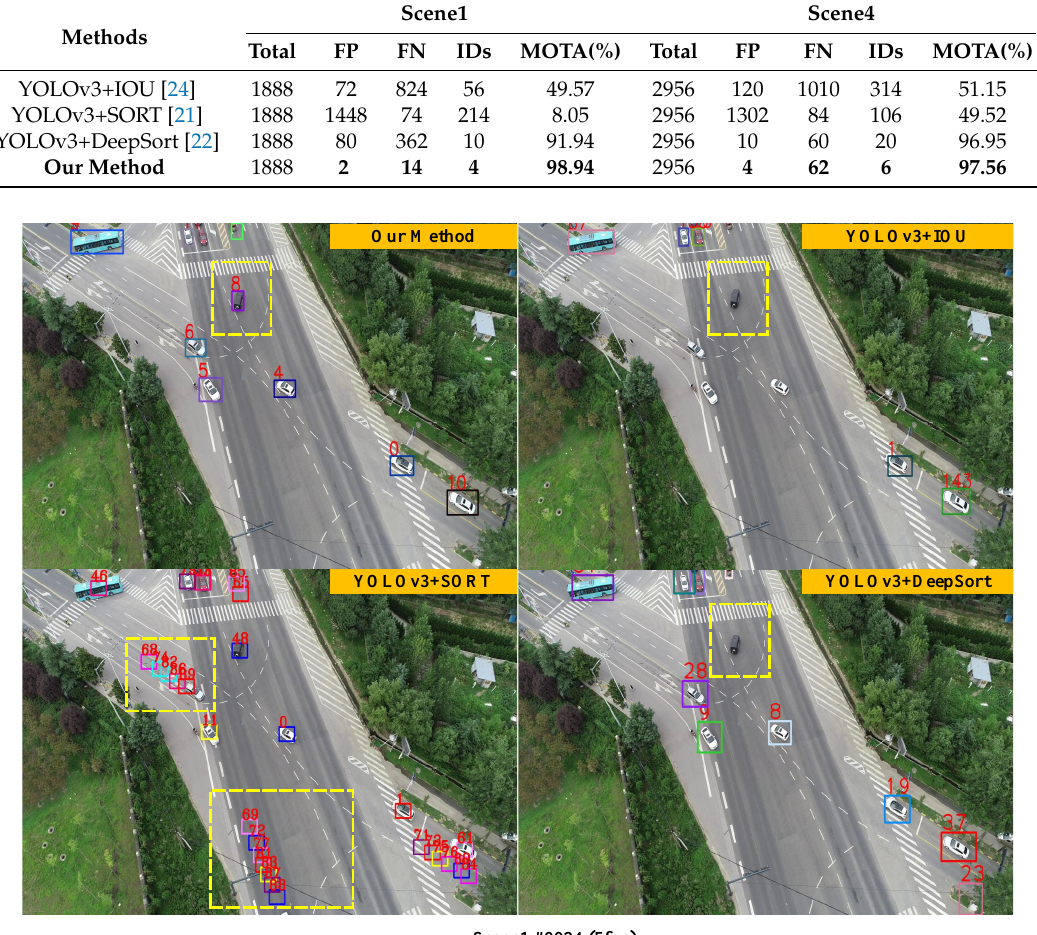
Figure 11. Tracking results of four tracking algorithms in Scene 1 with frame rate of 5 fps, enlarged to show the tracking effect more clearly. Scene 1 was an intersection with a complex background and vehicle movement. This set of results showed that YOLOv3 + SORT easily lost the target and entered the prediction stage, causing target ID to be frequently